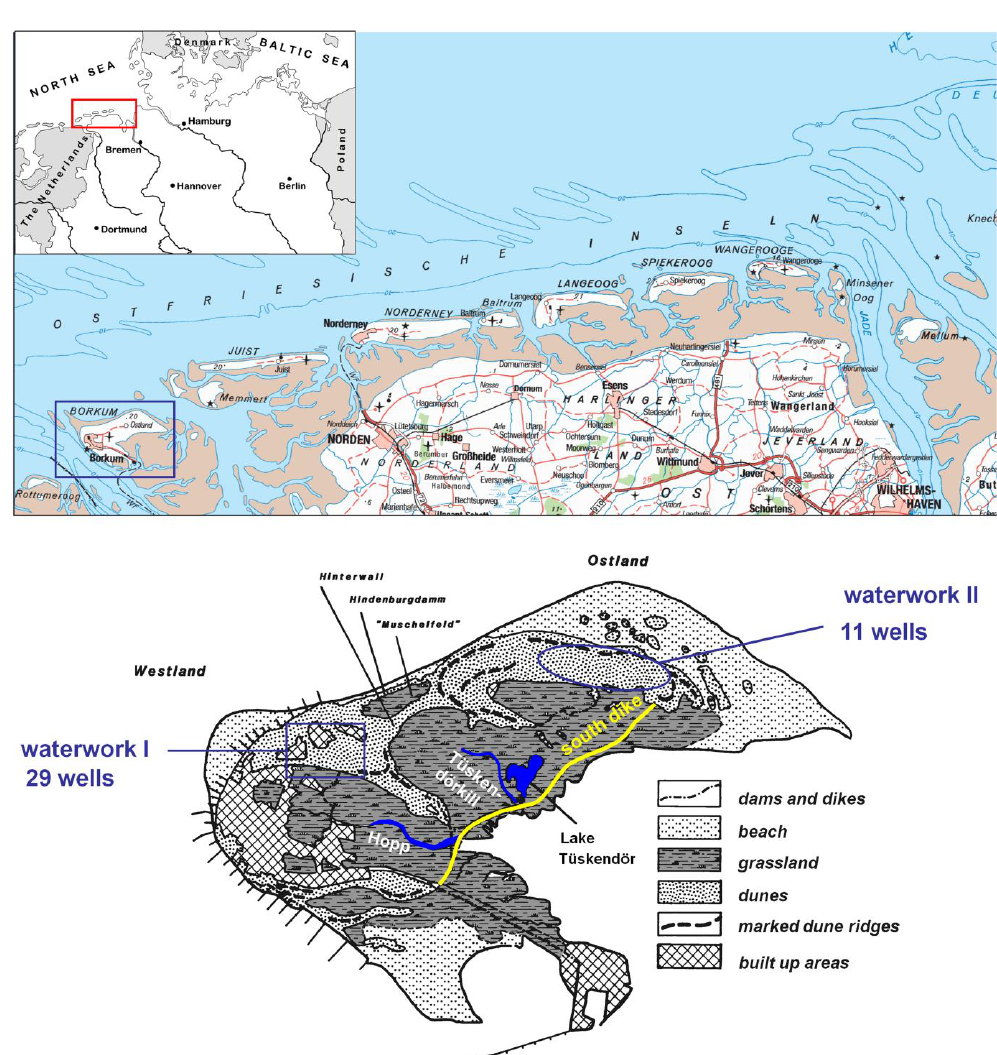
Fig. 1. Top panel: location map of study area, bottom panel: North Sea Island of Borkum with its two waterworks (WW): WW I Waterdelle and WW II Ostland and the two major rivers.